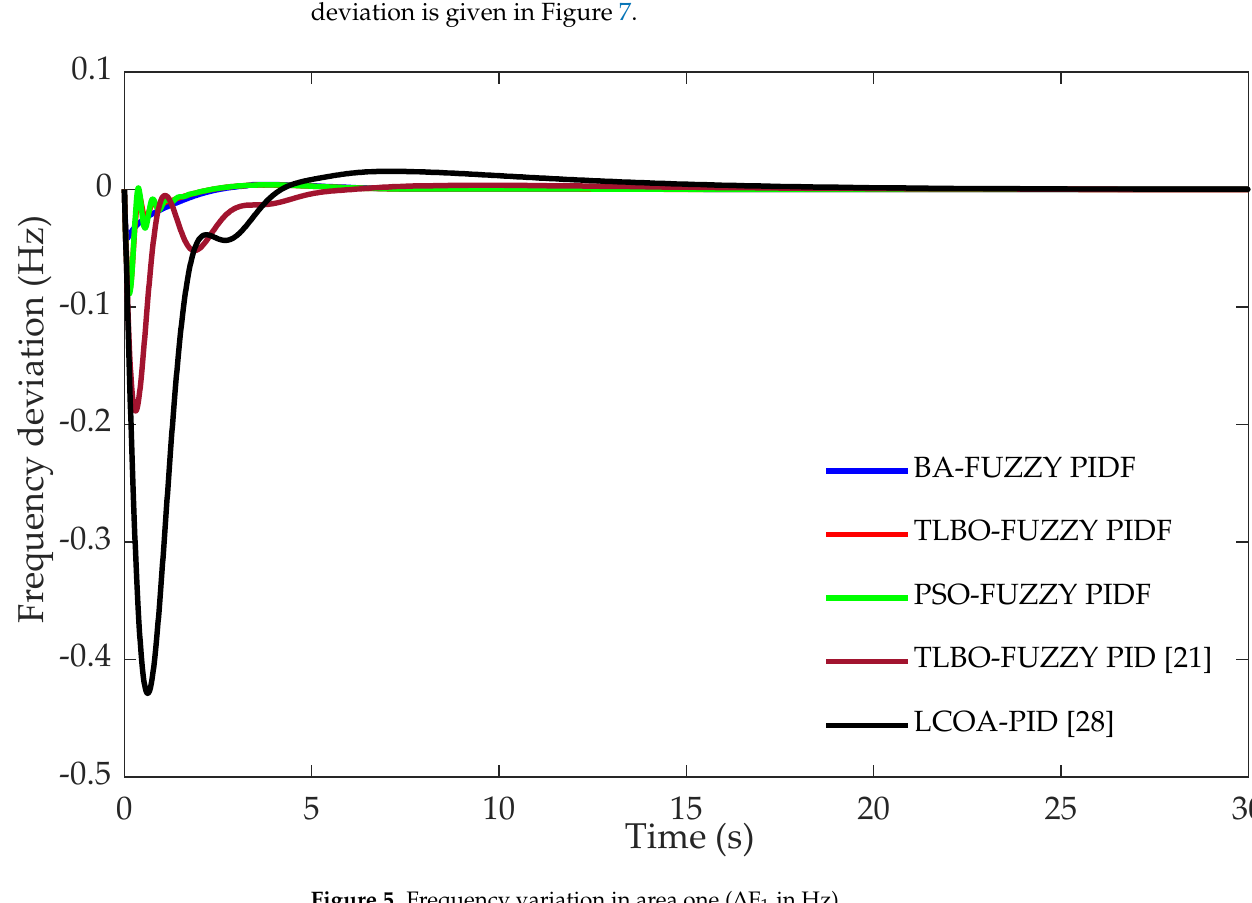
Figure 6. Frequency variation in area two ( ∆ F 2 in Hz).